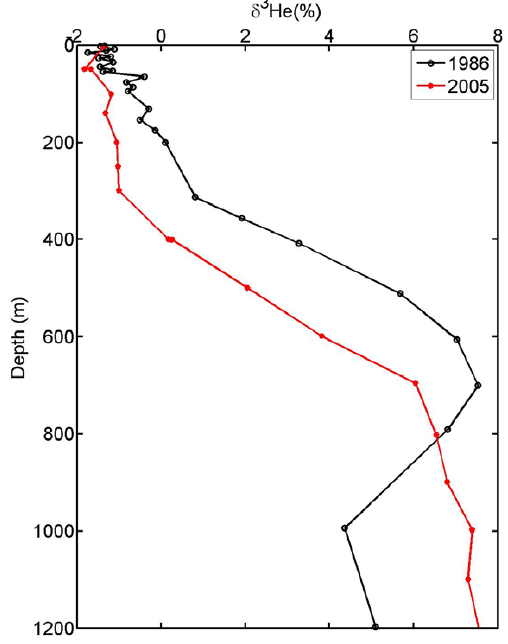
Figure 4. Representative profiles of δ 3 He in the upper 1200m of the water column in 1986 (black) and 2003–2006 (red). The pro- files illustrate that in 1986 there was much higher δ 3 He in the main thermocline and a larger gradient between the thermocline and the mixed layer than there was in 2006. This drives the observed greater 3 He flux in the 1980s compared to the